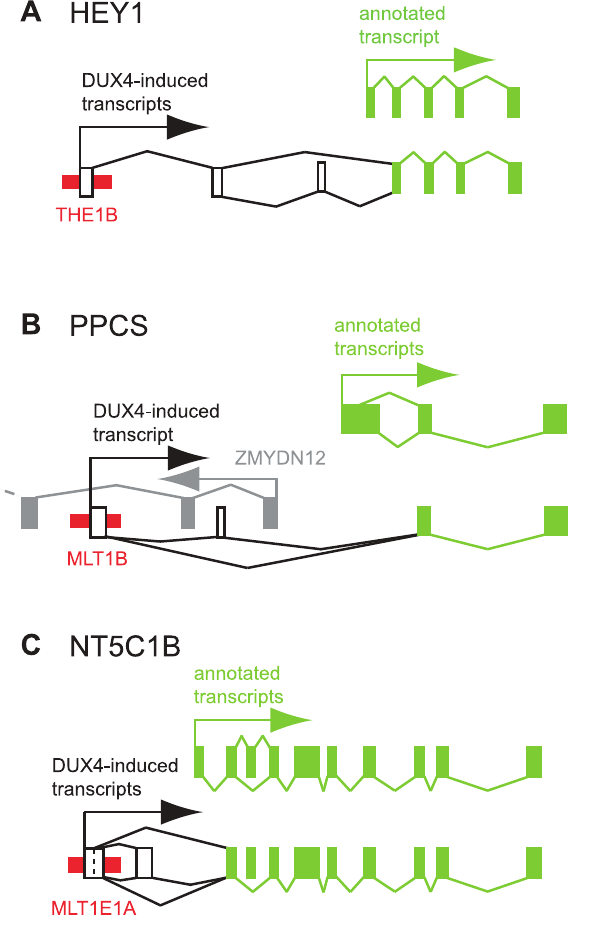
Figure 4. Examples of DUX4-bound repeats that function as alternative promoters for annotated genes. In each panel, thin red boxes depict DUX4-bound repetitive elements. Exons of previously annotated transcripts are depicted as green boxes, with alternative DUX4-induced exons as empty boxes (not to scale). Arrows show the direction of transcription. Diagonal lines show splicing, with alternative splice forms shown above and below the exons. (A) HEY1 . (B) PPCS . An upstream, divergently transcribed gene, ZMYDN12 , is shown in gray. (C)